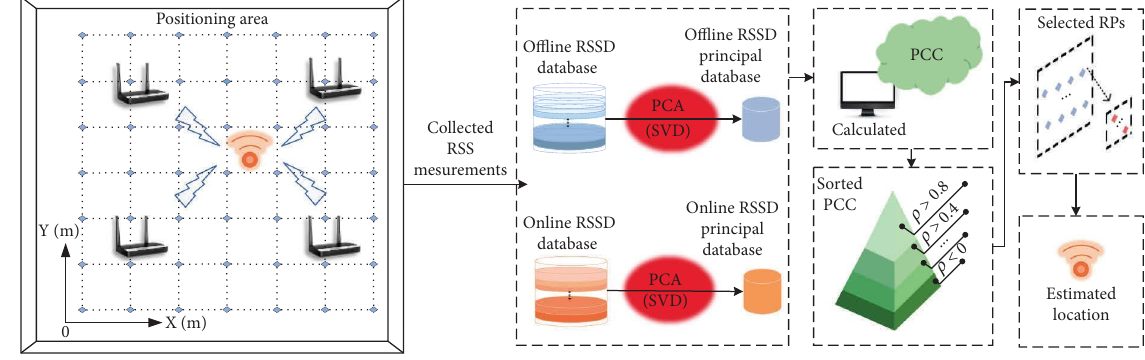
Figure 1: Te structure of the proposed RSSD-PCA-PCC positioning system. Table 2: Te ofine RSS fngerprint database.